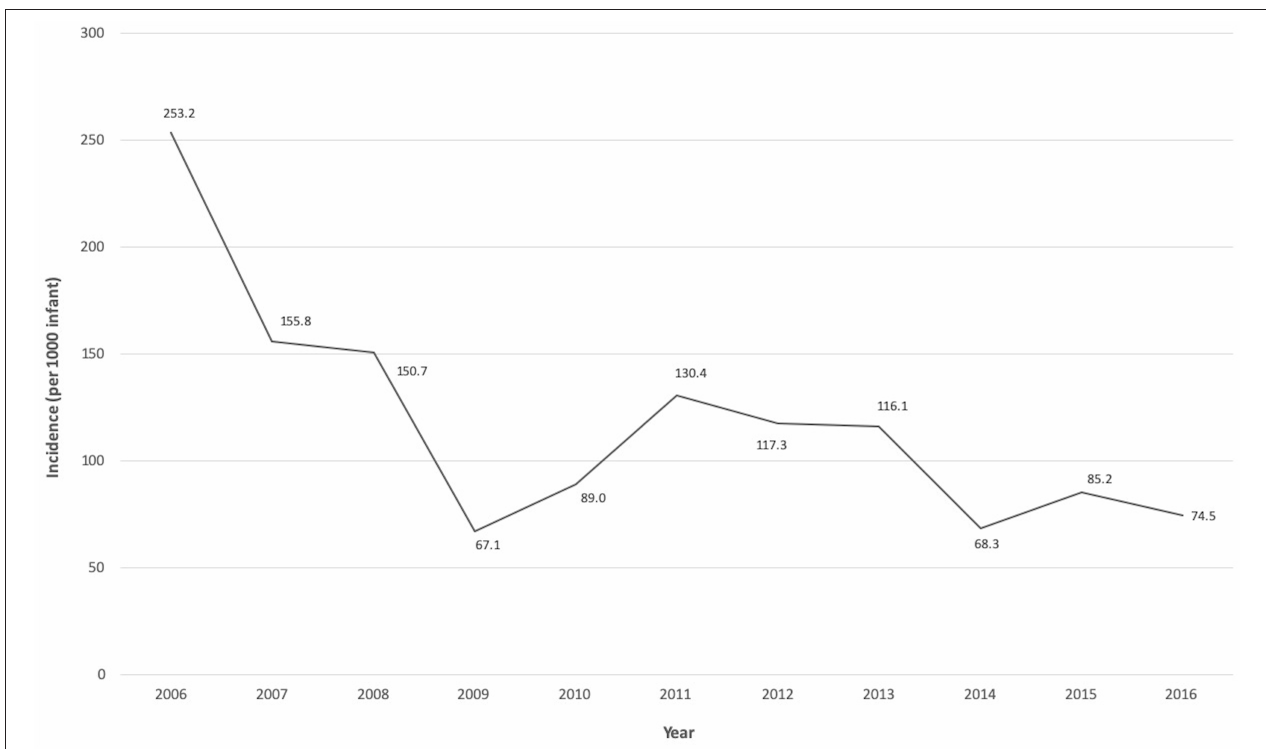
FIGURE 1 | Trends of late-onset sepsis incidence over the 11-year study period.